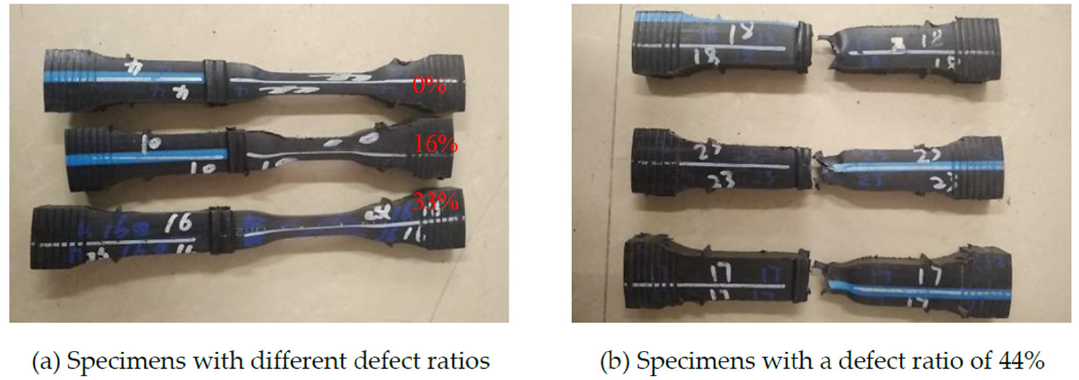
Figure 4. Creep failure specimens of HDPE under a load of 9 MPa and at a temperature of 40 °C.